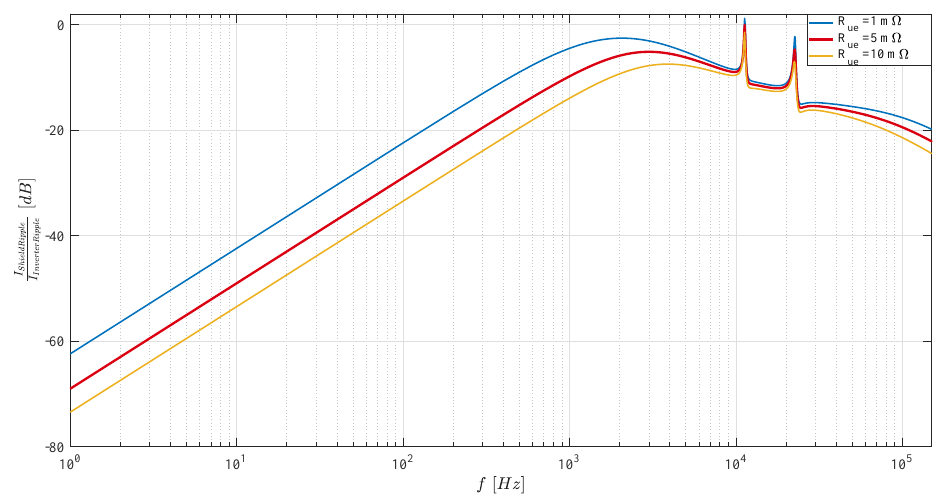
Figure 8. Proportion of shield and inverter ripple currents in the frequency function with three different contact resistance.